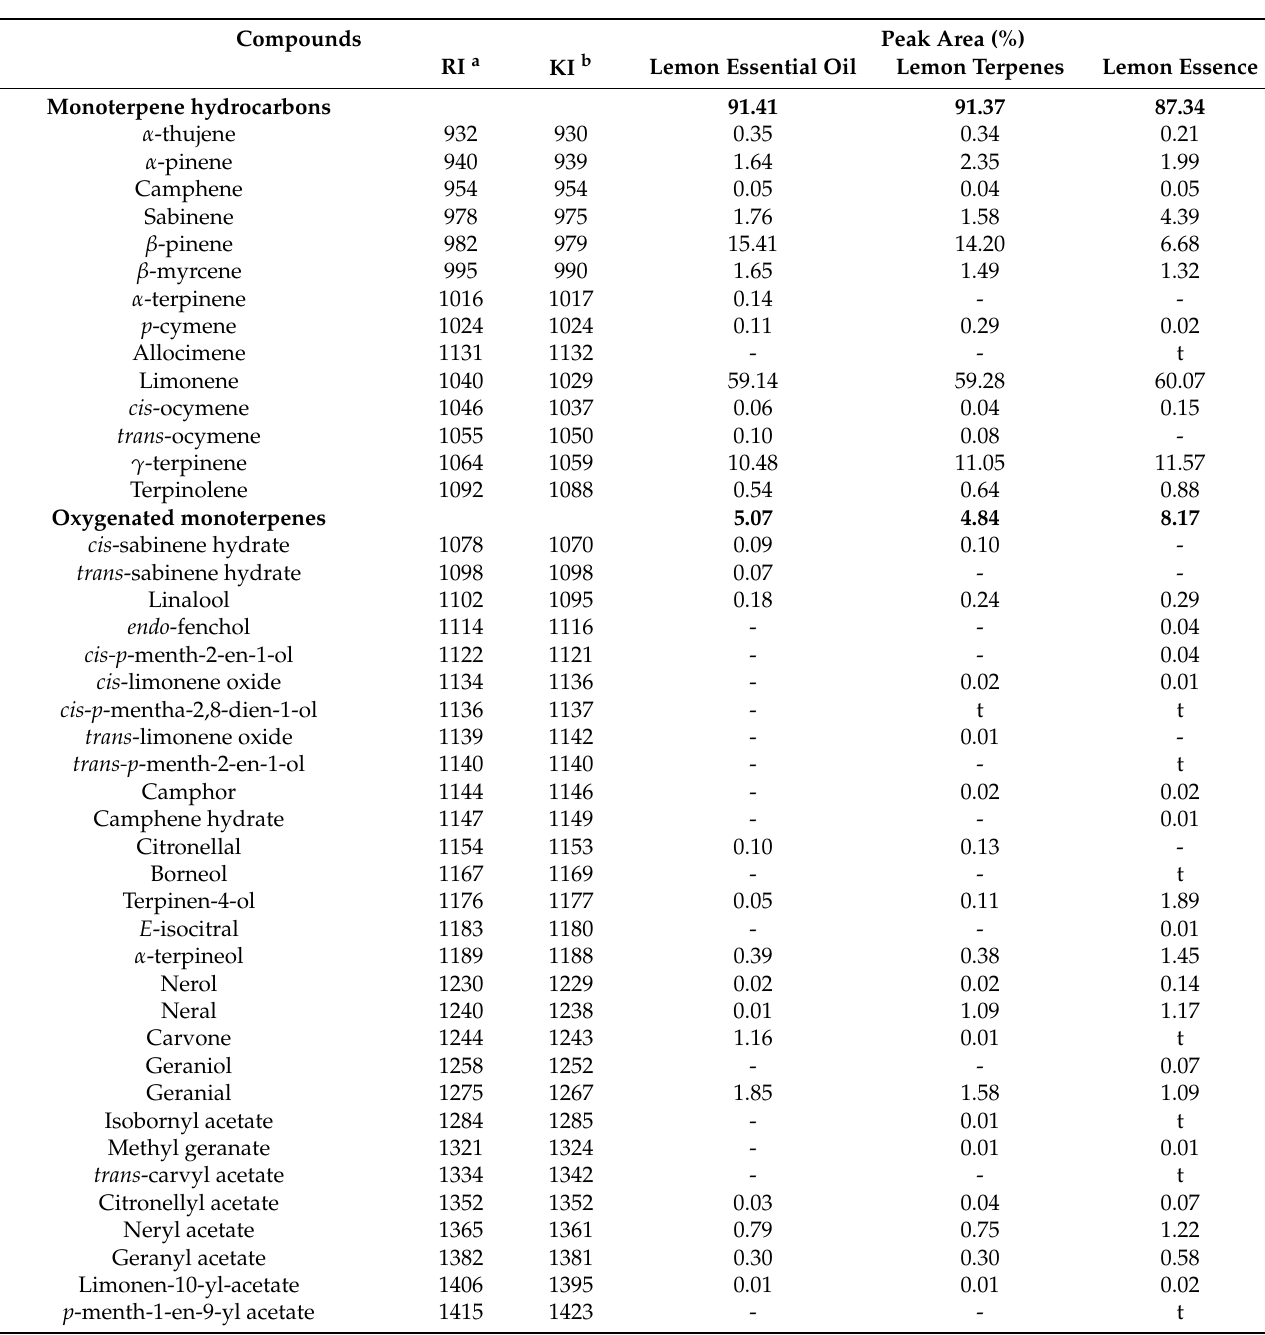
Table 1. Chemical constituents of essential oil, terpene fraction and essence from the fruit peels of C. limon (L.) Burm. f.